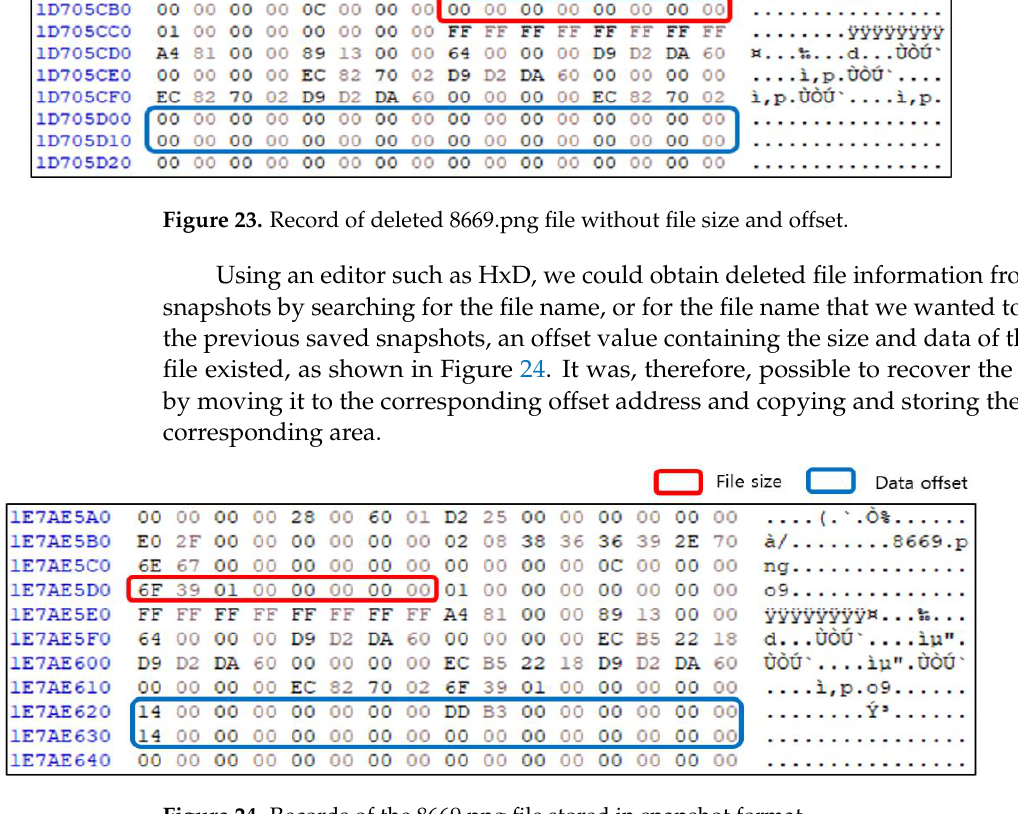
Figure 25. Recovery of deleted files in JFFS2 by verifying file versions. 5.2.3. UBIFS